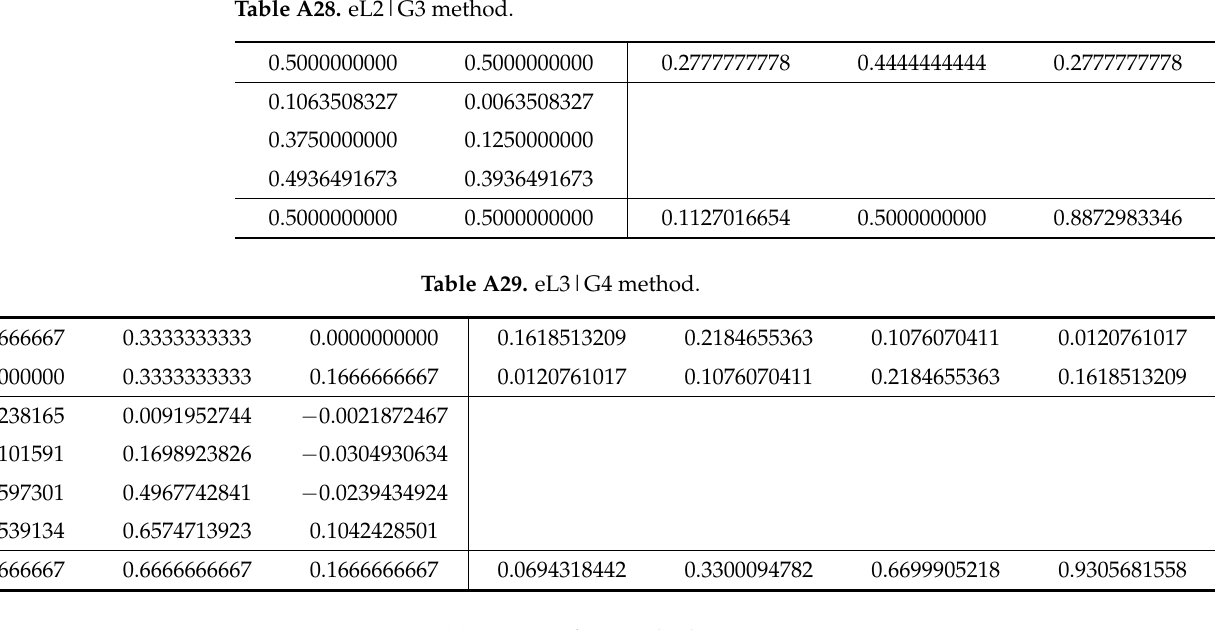
Table A30. eL4|G5